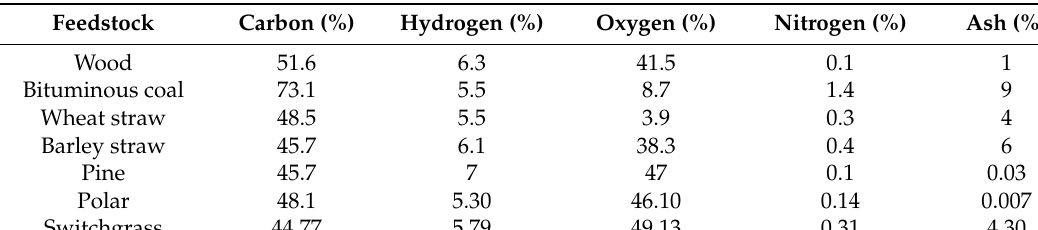
Table 2. Chemical characteristics of biomass [9].